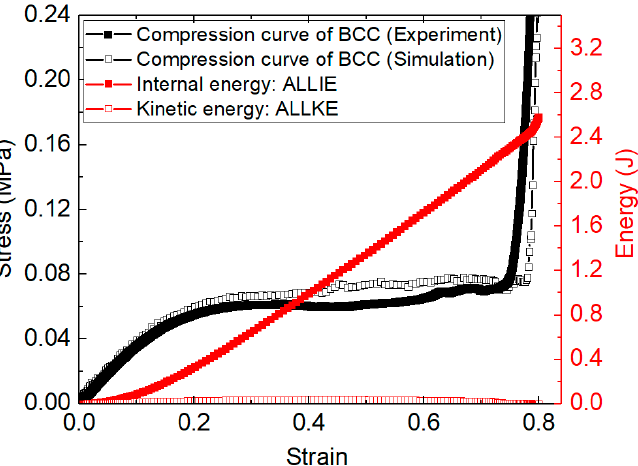
Figure 7. Comparison of compression stress–strain curves between experiment and simulation, and the comparison between internal energy and kinetic energy during the simulation process.